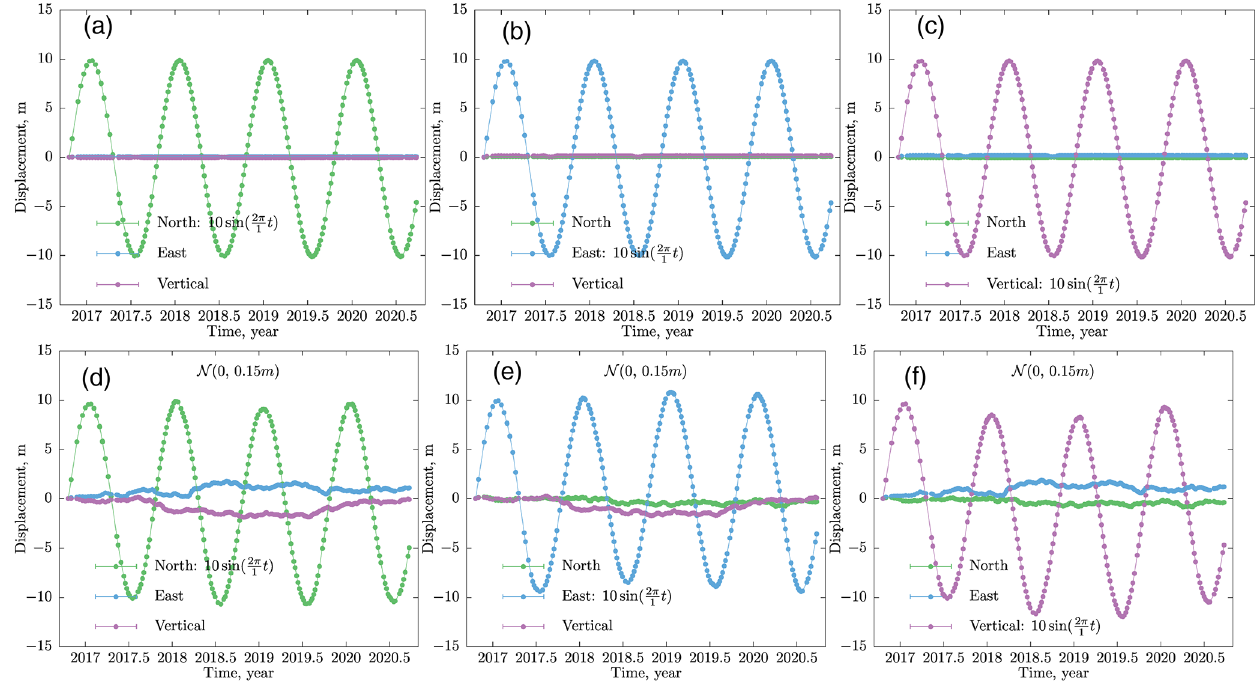
Figure 2. Results of numerical simulations demonstrating the ability of this technique to reconstruct input signal in one of components. Equations of input signals are shown in corresponding subfigure legends; t is time. Harmonic input signals are assumed. Gaussian noise with a mean value of zero and standard deviations of 0.15m (which is approximately 10% of the signal) is added to subfigures in the second